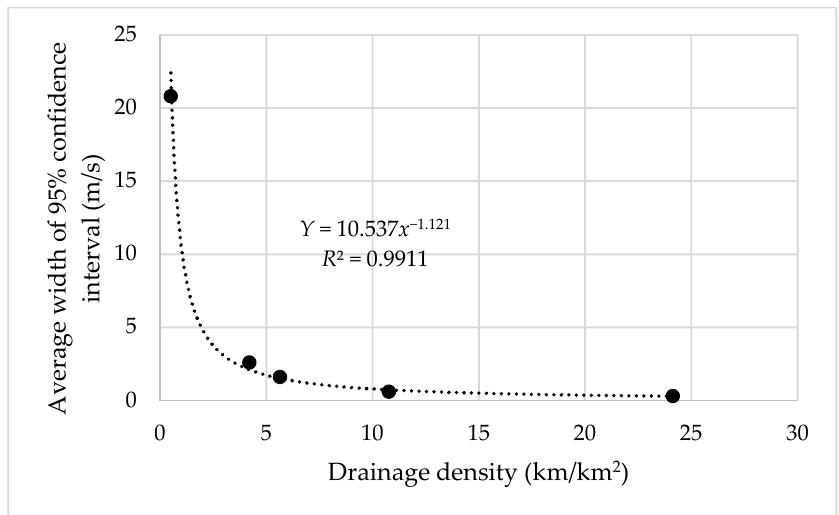
Figure 4. Changes of 95% confidence interval depending on drainage density.